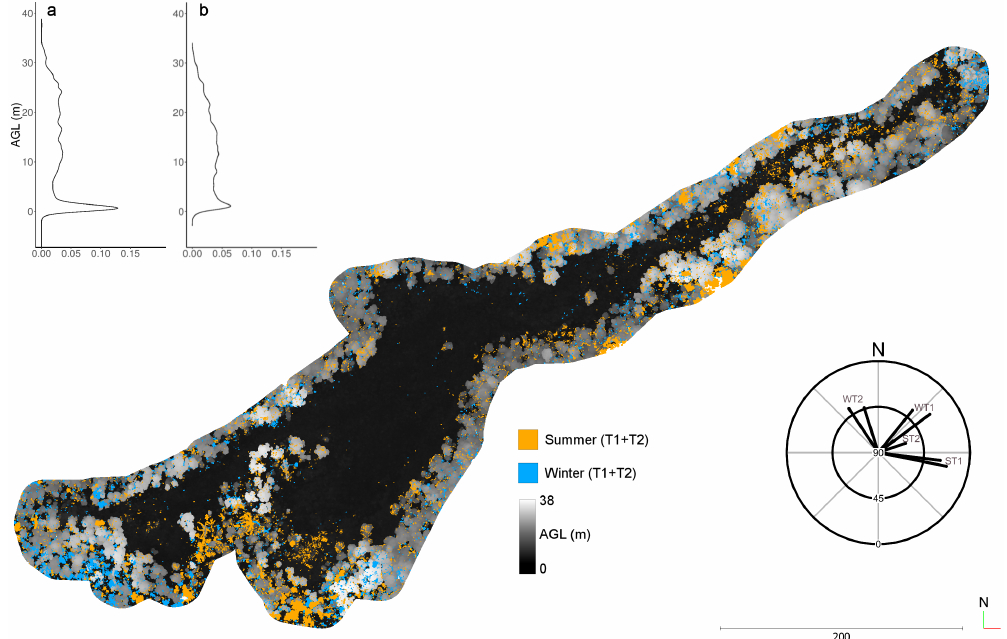
Figure 16. (main) Dense point clouds of reconstructed points within 0.5 m distance to alternate season point cloud (black to white). Unique points in summer (orange) and winter (blue). Relative frequency at different heights AGL for ( a ) summer and ( b )